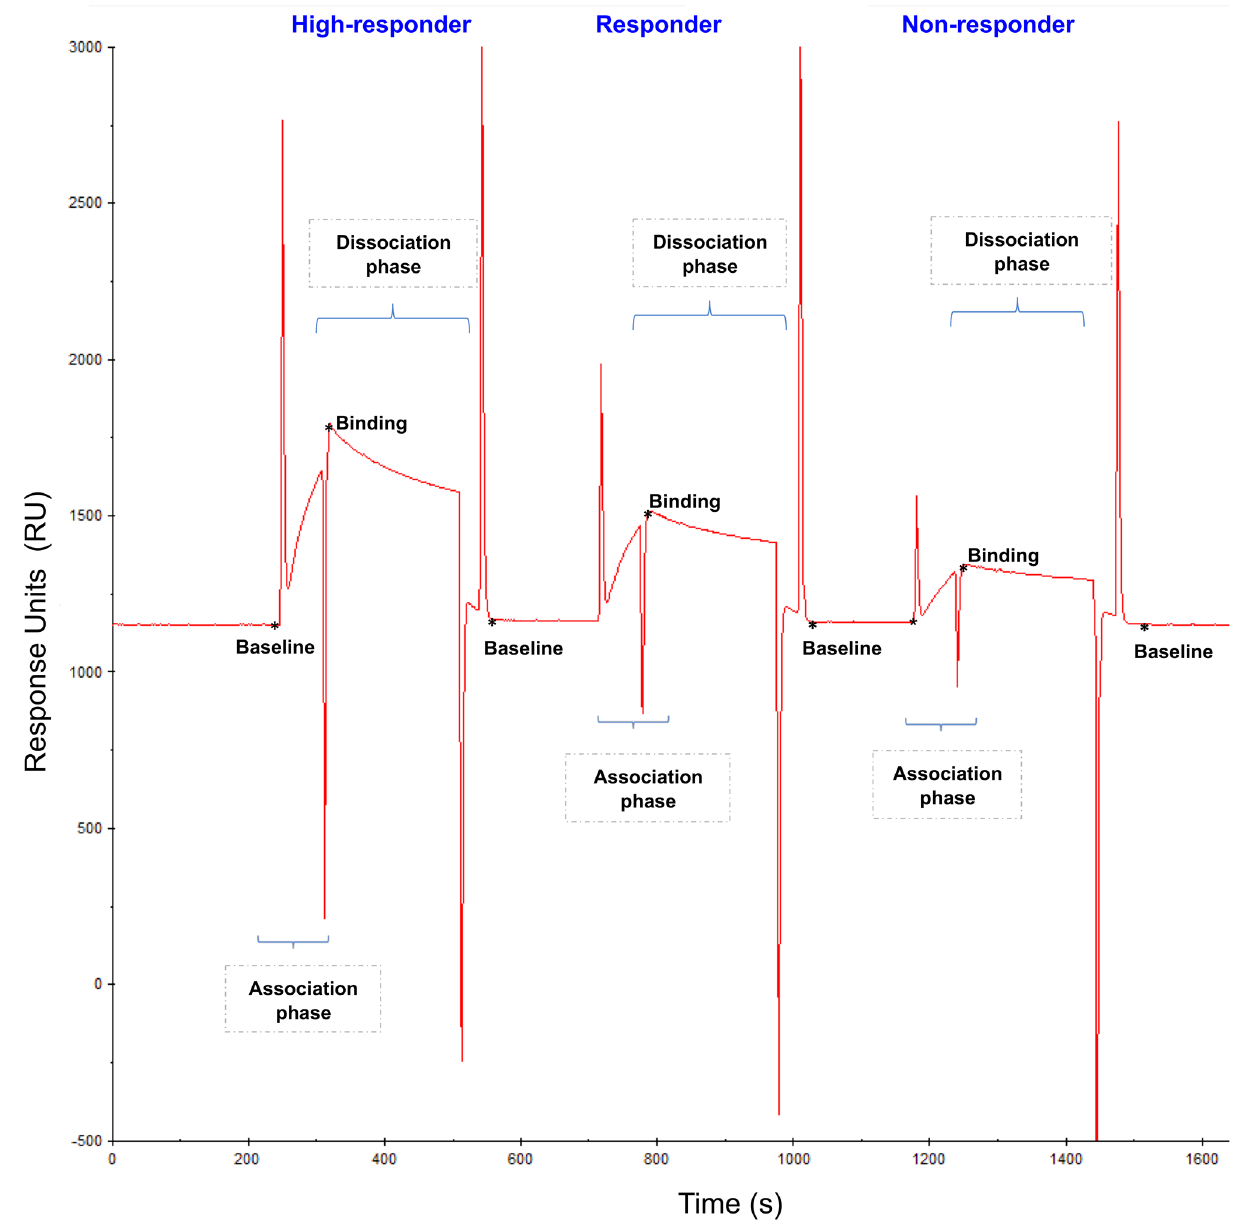
Figure 4. Representative SPR sensorgrams corresponding to the different groups of subjects included in the study. During SPR experiments, interaction between the PCV13 molecules immobilised in the chip and the serum anti-PnPs IgG occurs, changing the refractive index at the surface of the gold film and increasing signal intensity. Response units (RU) are used to describe the increase in the signal, where 1 RU is equal to a critical angle shift of 10 −4 deg. At the start of the experiment all immobilised PCV13 molecules have not been exposed to serum anti-PnPs IgGs and the RU correspond to the starting critical angle (baseline). During the association phase, serum samples are injected into the flow cell and serum anti-PnPs IgGs bind to the immobilised PCV13 molecules, increasing the signal intensity. The shape of this curve can be used to measure the rate of association. This maximum RU relates to the maximum concentration of serum anti-PnPs IgGs that specifically interact with immobilized PCV13. During the dissociation phase, serum anti-PnPs IgGs are removed from the chip by the continuous flow. The surface is regenerated at the end of the experiment and returned to the starting critical angle (baseline) to start the next experiment. *Characteristically report points of SPR sensorgram: Baseline report point refers to the value of the critical angle at the star of the experiment. Binding report point refers to the maximum level of RU obtained after serum